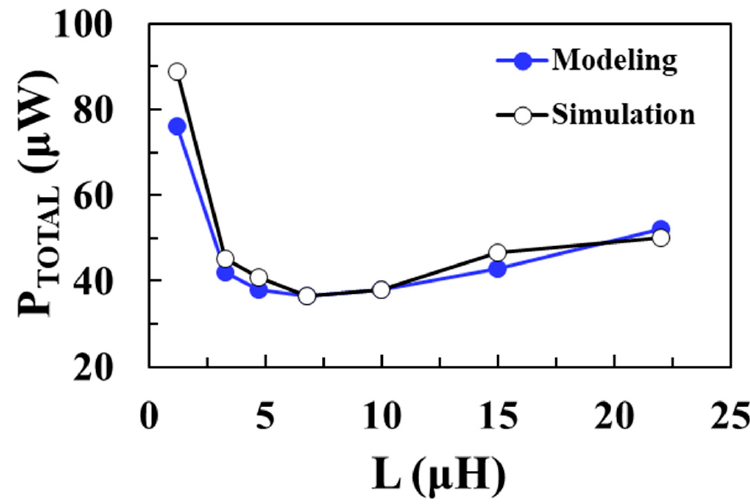
Figure 13. Total loss according to inductance for an input voltage of 0.1 V and comparison with the modeling results.